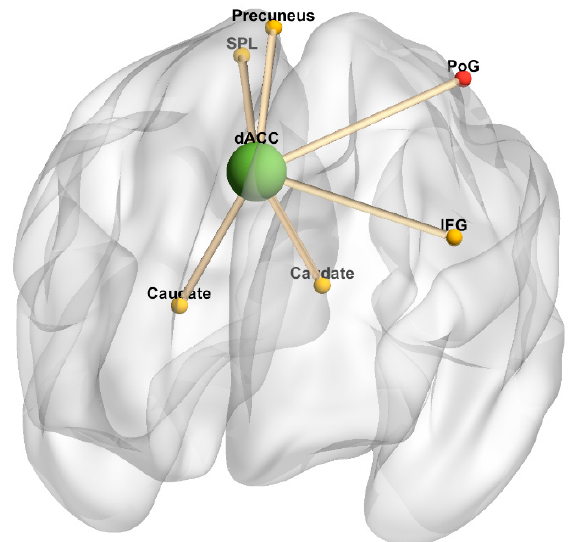
Figure 6. Dorsal anterior cingulate cortex connectivity 3-dimensional rendering. Figure represents task-independent, fatigue-related connectivity in the multiple sclerosis group; there were no significant differences between conditions in the healthy control group. The seed is denoted by a green sphere; regions with increased connectivity to the seed in the 2-back condition are denoted by yellow spheres, and regions with increased connectivity to the seed in the 0-back condition are denoted by red spheres. Cerebellum was omitted. Anterior orientation is in the front of the figure, right hemisphere is on the left side, and left hemisphere is on the right side. Abbreviations: dACC, dorsal anterior cingulate cortex. IFG, inferior frontal gyrus. PoG, postcentral gyrus. SPL, superior parietal